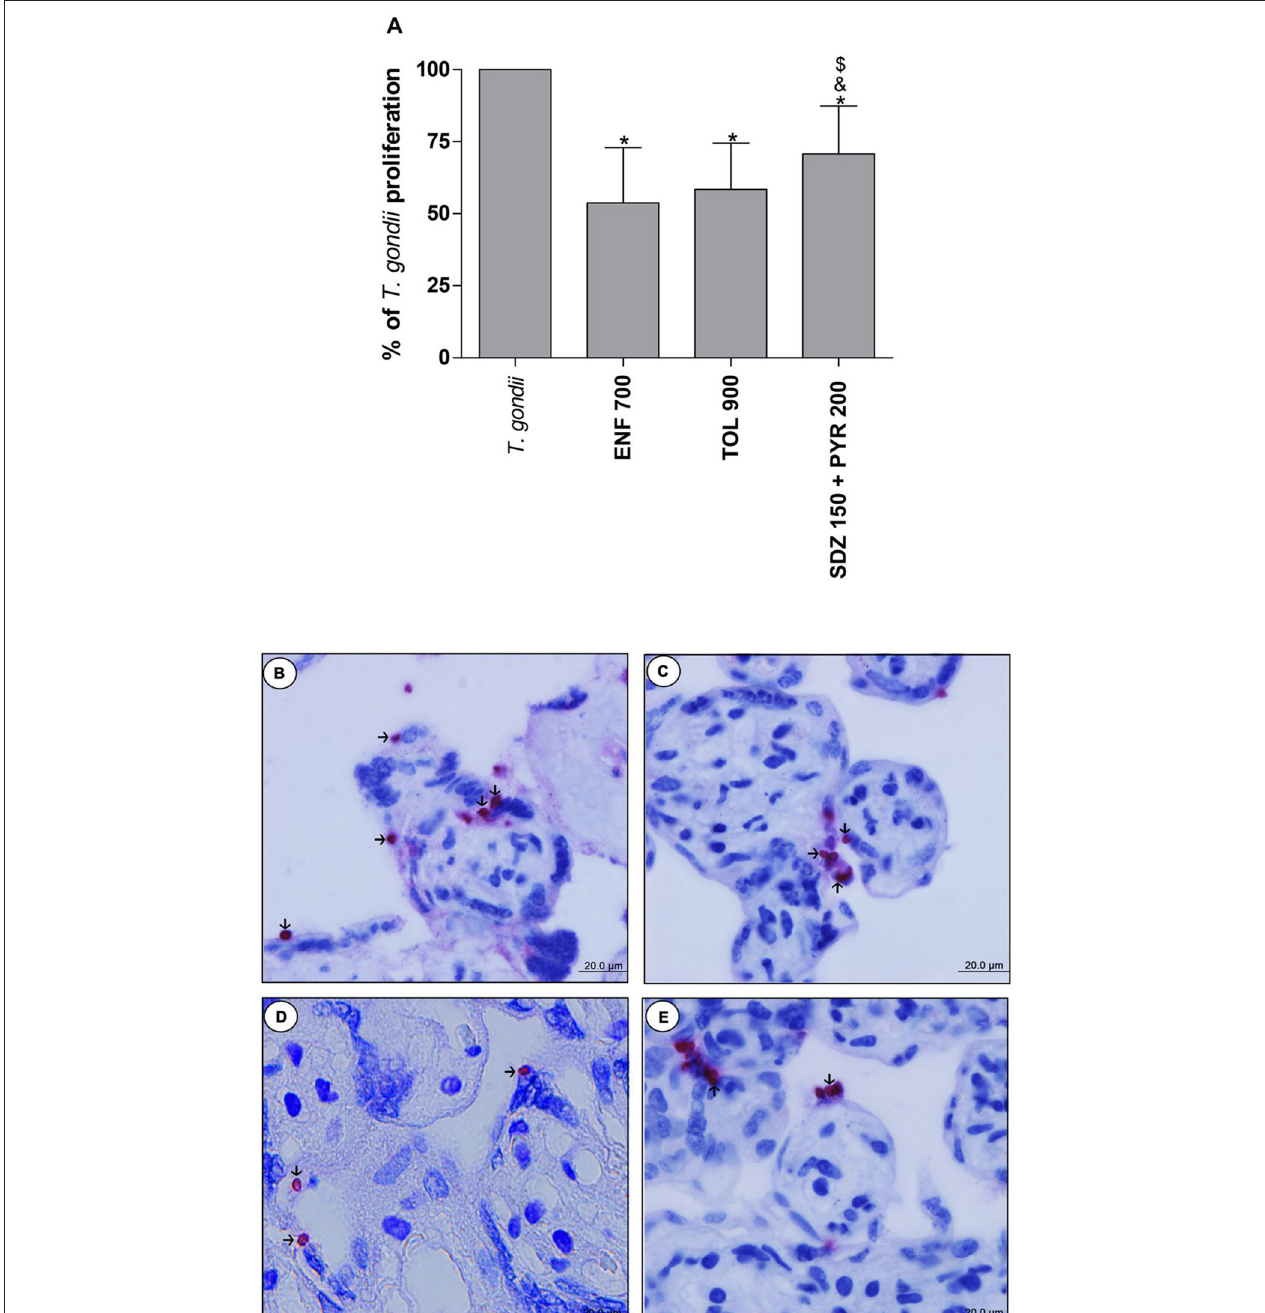
FIGURE 6 | Percentage (%) of T. gondii proliferation in human villous explants treated with different drugs. Villi were collected and cultured for 24h, infected with T. gondii (RH-2F1 clone), and after 24h, treated or not with the different drugs ( µ g/mL): enrofloxacin (ENF), toltrazuril (TOL), or combination of sulfadiazine and pyrimethamine (SDZ + PYR) for additional 24 h. Next, the villous explants were macerated for β -galactosidase assay.Data were analyzed as (%) of T. gondii proliferation (A) . Data were expressed as mean ± SEM of three independent experiments in nine replicates. Significant difference in relation to untreated and infected cells ( T. gondii ) ( ∗ P < 0.05), ENF ( & P < 0.05), and TOL ( $ P < 0.05). Differences between groups were analyzed by One-Way ANOVA with the Bonferroni multiple comparison post-hoc test. Representative photomicrographs of untreated and infected villous explants (B) , or treated with ENF (C) , TOL (D) , or combination of SDZ + PYR (E) . Immunohistochemical sections counterstained by Harris’s hematoxylin. Arrows indicate immunolocalization of parasites by fast red naphtol. Bar scale: 20.0 µ m.